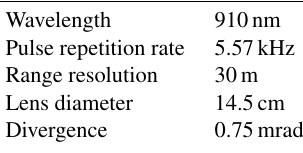
Table 2. Vaisala CL31 ceilometer